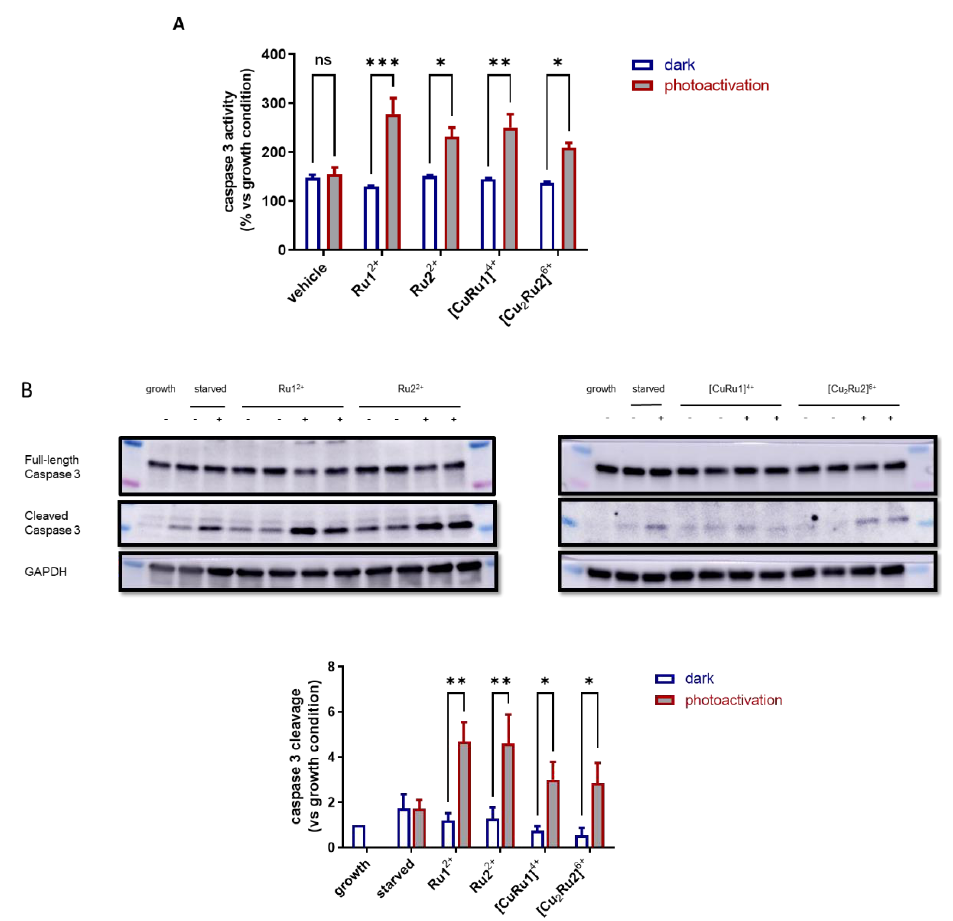
Figure 4. Effect of Ru(II) complexes on caspase 3 activation in ovarian cancer cells after photosensitization. A2780 cells were treated with each Ru(II) complex, Ru1 2+ , Ru2 2+ , [Cu Ru1 ] 4+ and [Cu 2 Ru2 ] 6+ ,